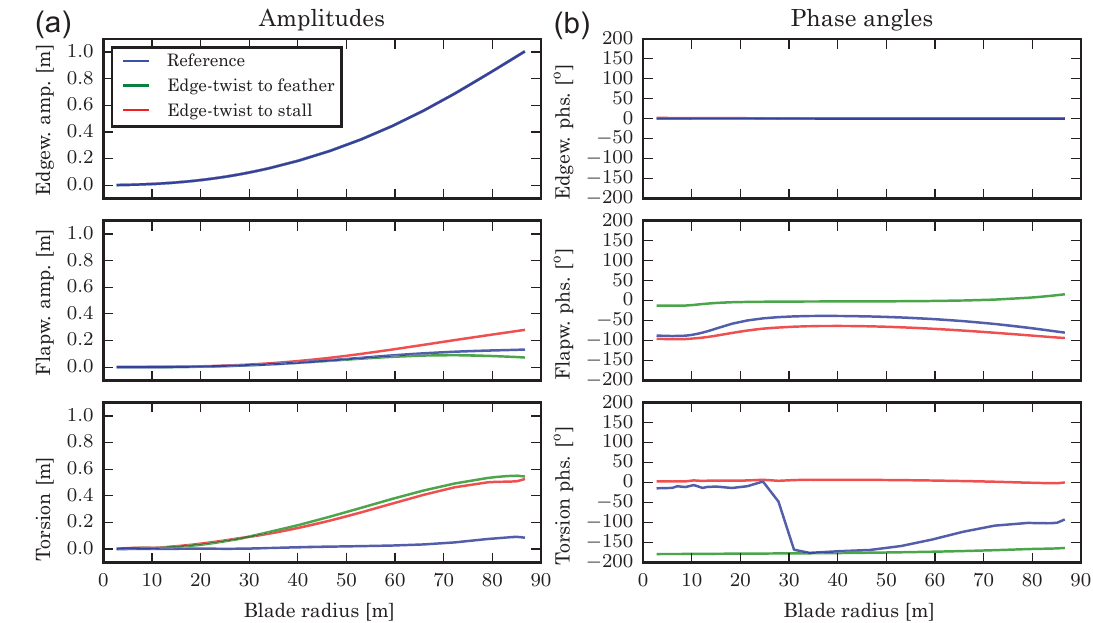
Figure 13. Amplitudes (a) and phase angles (b) of the first aeroelastic edgewise mode at 16ms − 1 wind speed for the reference (blue), and edge–twist to feather (green) and stall (red) coupled DTU 10MW RWT blades. Coupling coefficients are γ x = ± 0 . 1 constant along the blade. Amplitudes are normalized to 1.0m tip deflection in the edgewise direction, and phase angles are relative to the edgewise tip deflection.